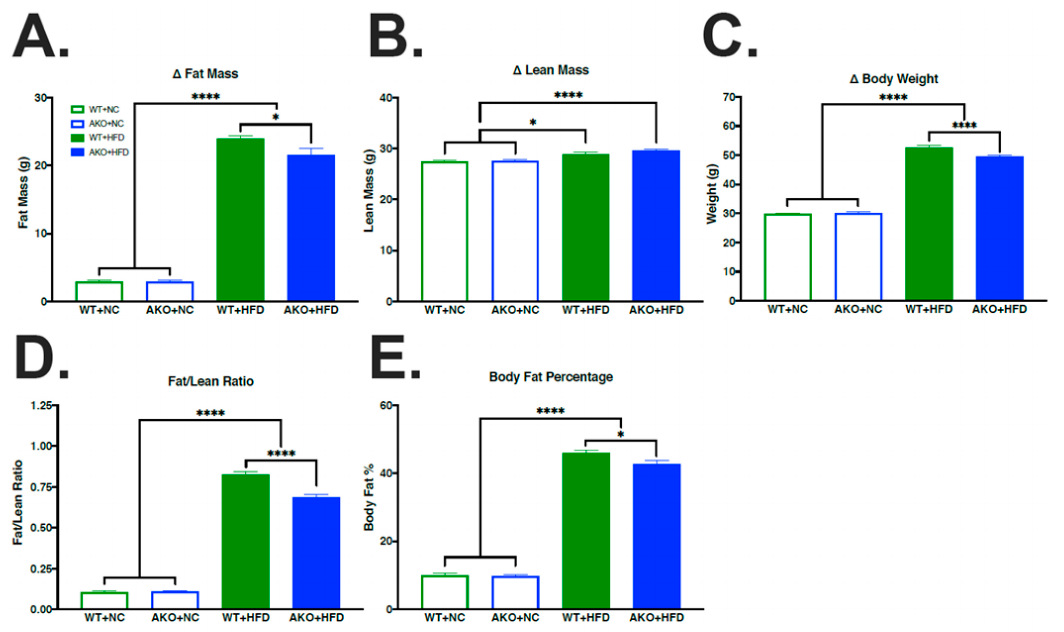
Figure 1. HFD increases fat mass, lean mass, body weight, fat/lean ratio, and body fat percentage. ( A – E ) Change in fat mass, lean mass, body weight, fat/lean ratio, and body fat percentage in WT mice fed NC, WT mice fed HFD, AKO mice fed NC, and AKO mice fed HFD (n = 22–47). Data analyzed via one-way ANOVA and Tukey’s post-test. * p < 0.05, **** p < 0.0001. HFD leads to increase in fat mass ( p < 0.0001; ( A )), lean mass ( p < 0.013; ( B )), body weight ( p < 0.0001; ( C )), fat/lean ratio ( p < 0.0001; ( D )), and body fat percentage ( p < 0.0001; ( E )). AKO mice fed HFD had decreased fat mass ( p < 0.044; ( A )), body weight ( p < 0.0001; ( C )), fat/lean ratio ( p < 0.0001; ( D )), and body fat percentage ( p < 0.029; ( E )) compared to WT mice fed HFD.